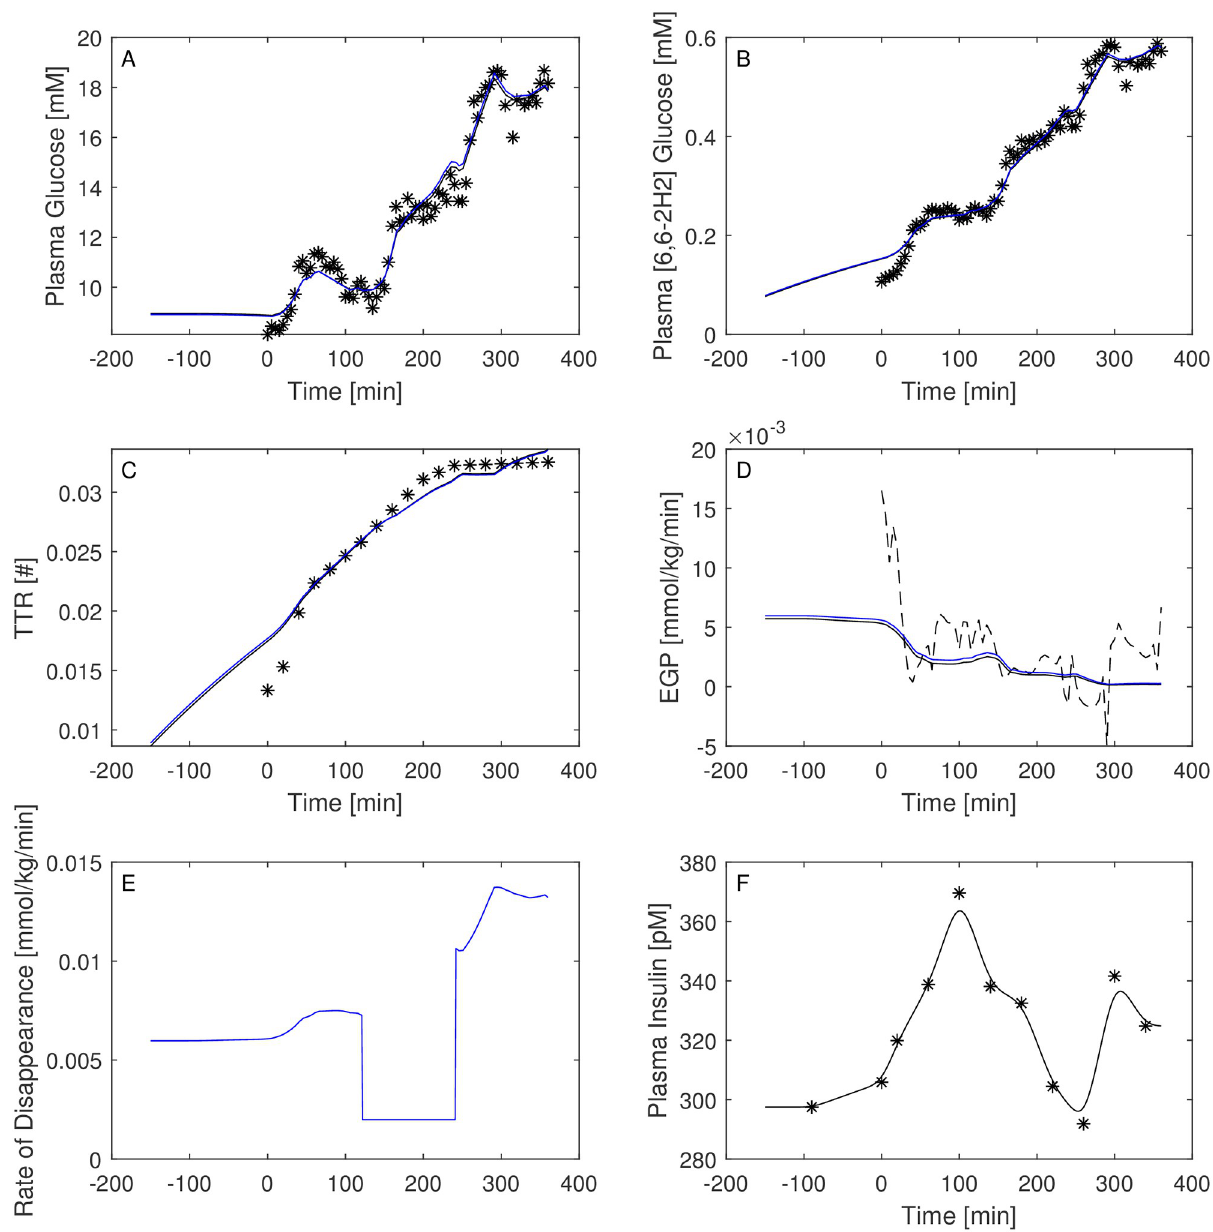
Fig 7. Predictions for Subject 5. Observed (asterisks) and predicted (line) variables over time (T2DM subject). EGP: Endogenous Glucose Production; TTR: Tracer to Tracee ratio. Plasma glucose concentration (Panel A); Plasma [6, 6-2H2]glucose (Panel B); TTR (Panel C); EGP (Panel D), dashed line is the predicted EGP with the Steele model; Rate of disappearance (panel E); Plasma Insulin concentrations (Panel F). All the observed points refer to data measured on day 2. Plasma glucose concentrations (panel A) are derived from the glucose intra-venous infusion to match plasma glucose observations from the OGTTs of day 1. Black lines in panels A, B, C, D and E are model predictions from WLS estimation procedure; blue lines derive from the estimation approach which uses autocorrelated errors.